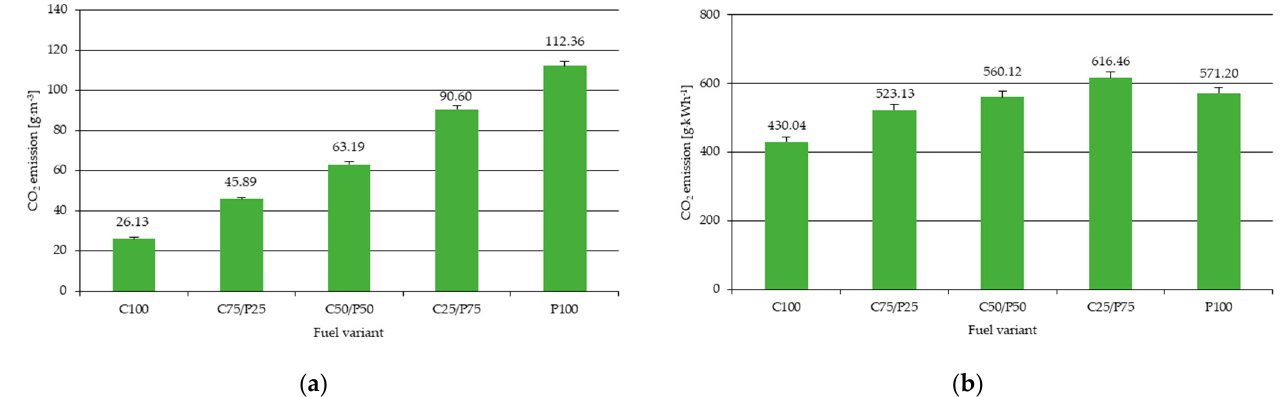
Figure 7. CO 2 emission per ( a ) 1 m 3 exhaust gas; ( b ) 1 kWh thermal energy.